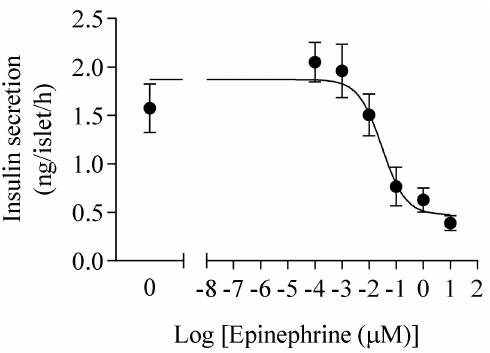
Figure 2. The epinephrine dose response for islets under 20 mM glucose condition ( n = 5). 3.2. Total Insulin Content Was Higher and Fractional Insulin Release Was Lower after Chronic Epinephrine